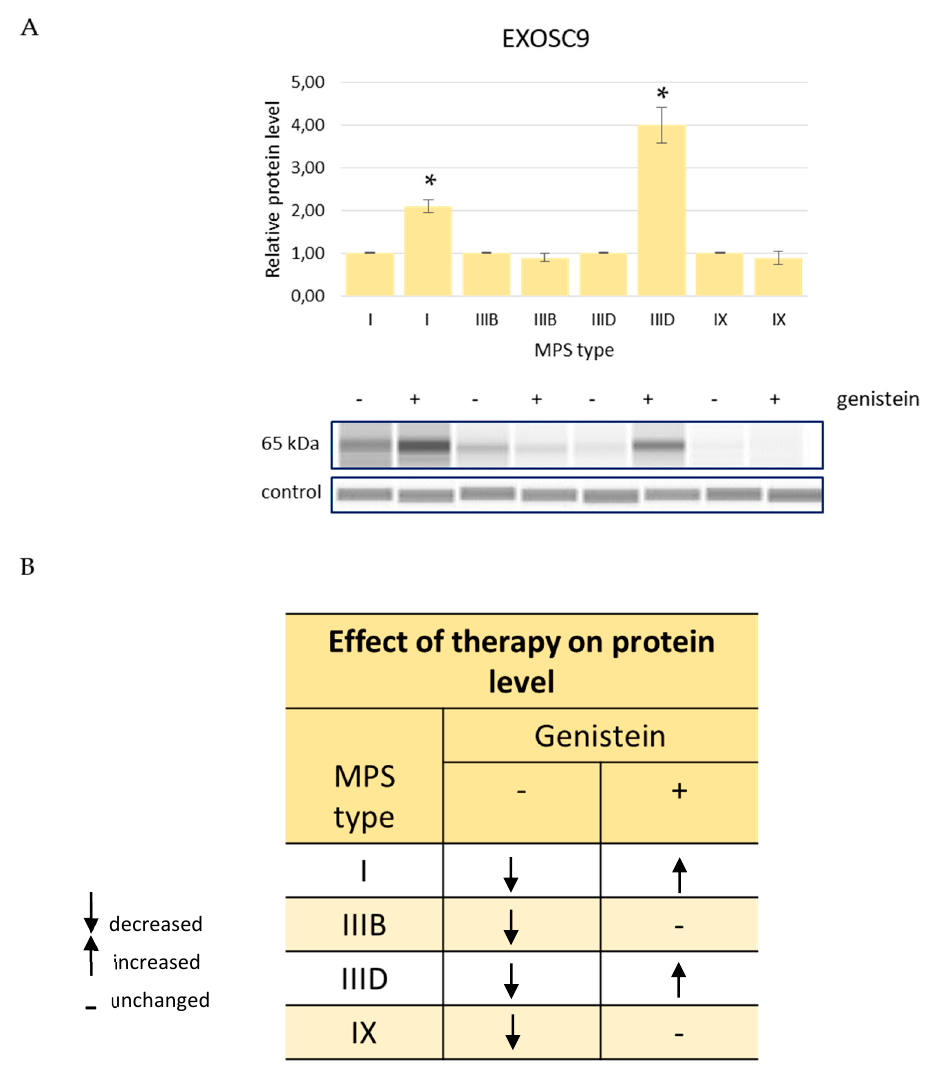
Figure 5. Levels of the EXOSC9 protein in fibroblasts of different types of MPS with (+) and without ( − ) treatment with 50 μ M genistein for 48 h (only MPS types which revealed significantly changed amounts of this protein relative to HDFa control cells (see Figure 4) are shown). Panel ( A ) shows representative blots and the quantification of the results by densitometry, where value 1 corresponds to the level of EXOSC9 determined in MPS cells not treated with genistein. Panel ( B ) shows the scheme of results where the column ( − ) indicates the levels of EXOSC9 in MPS cells relative to HDFa control while the column (+) indicates the levels of this protein in cells of the corresponding MPS types after 48 h of treatment with 50 μ M genistein relative to untreated MPS cells. Up-headed arrows indicate increased levels, down-headed arrows indicate decreased levels, and dashes indicate no significant changes. In panel ( A ), the results indicated by the columns are mean values from three independent experiments with error bars representing SD. Statistically significant differences relative to the untreated MPS cells ( p < 0.05) are indicated by asterisks (*).